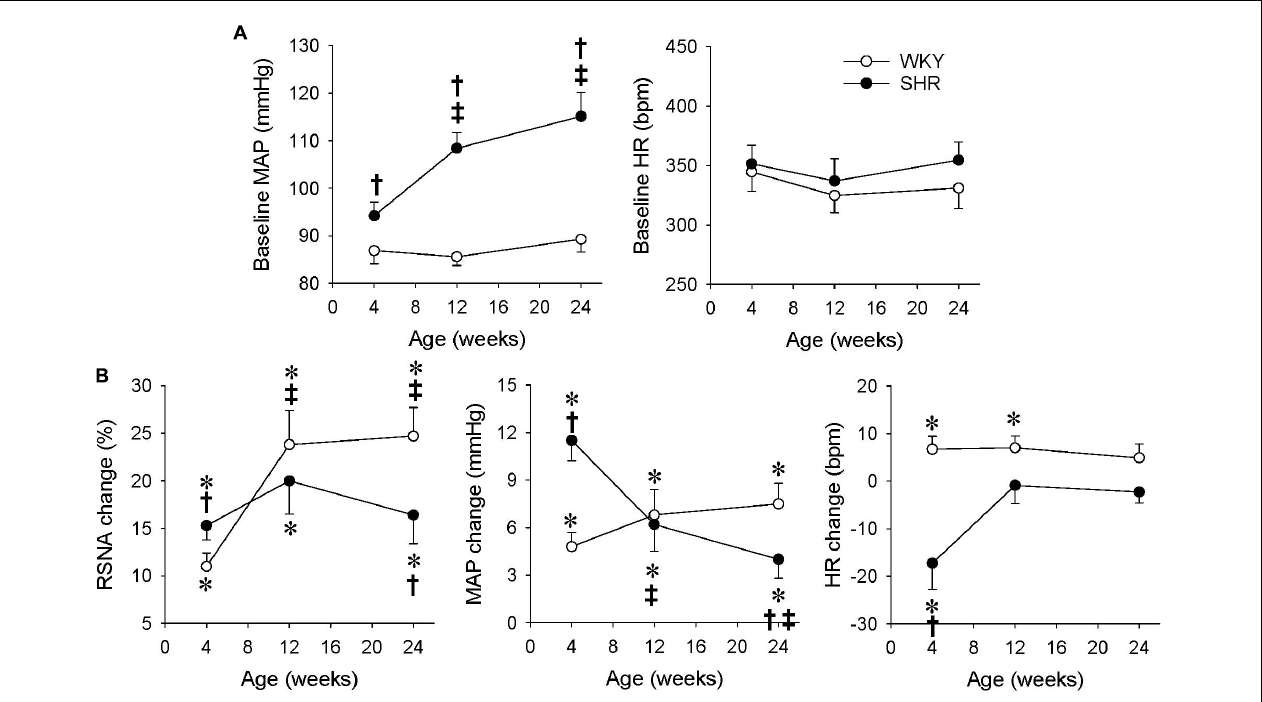
FIGURE 4 | Comparison of ERR in the WKY and SHR at the ages of 4, 12, and 24 weeks. The ERR was induced by renal infusion of capsaicin at 1 nmol/min for 20 min. (A) Baseline MAP and HR. † P < 0.05 vs WKY. ‡ P < 0.05 vs 4 weeks. (B) capsaicin-induced ERR. Values are mean ± SE. ∗ P < 0.05 vs the values before